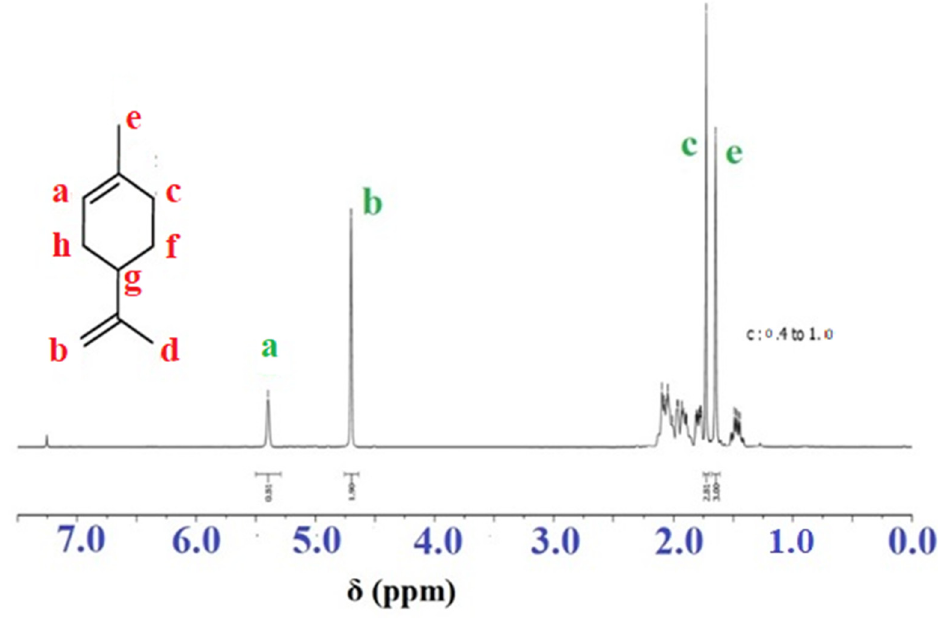
Figure 2. 1 H-NMR spectrum of the free radical polymerization reaction mixture of limonene with AIBN as initiator.